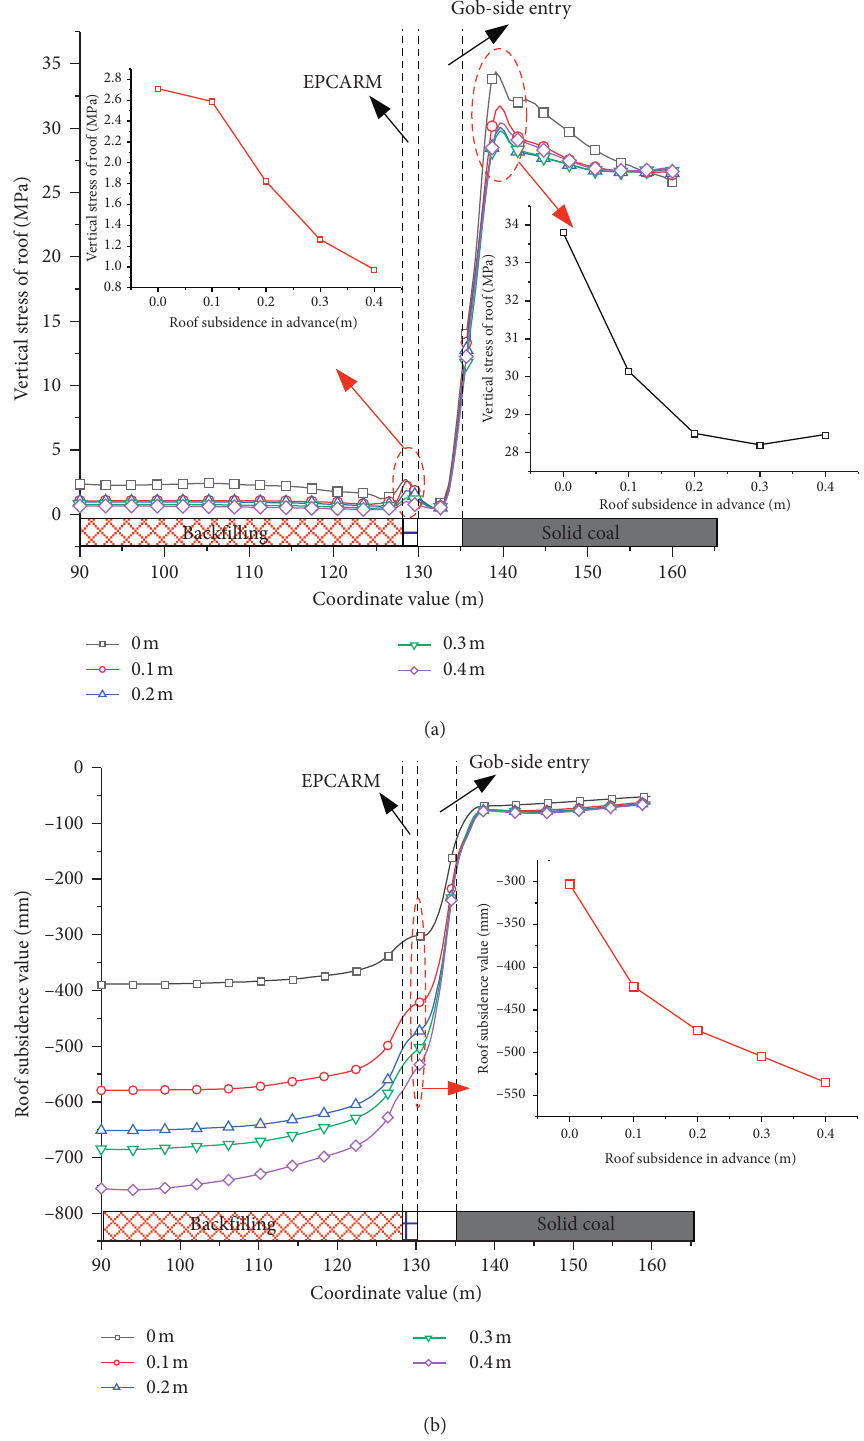
Figure 8: Roof deformation and stress variation of different roof advance subsidence values. (a) Stress law. (b) Deformation excavation until the next working face. The surrounding rock control effect of the gob-side entry is shown in Figure 9. As indicated by the six deformation monitoring points, the maximum subsidence of the entry roof was 0.294 m, and